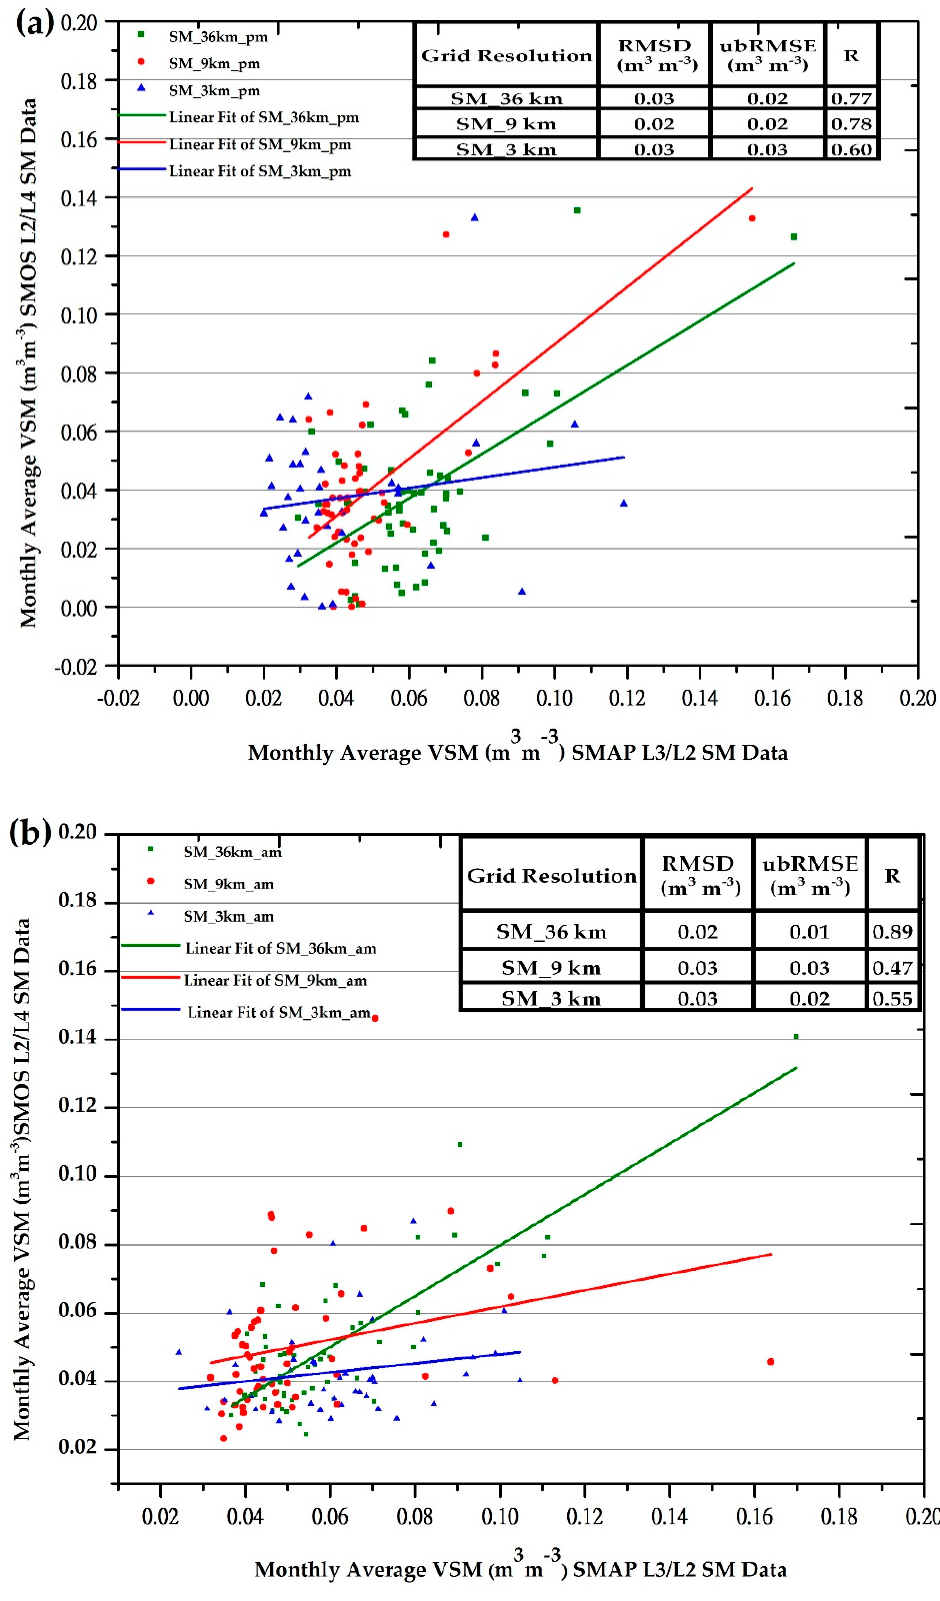
Figure 8. Comparison of soil moisture of SMAP SM products (L3/L2) with SMOS SM products